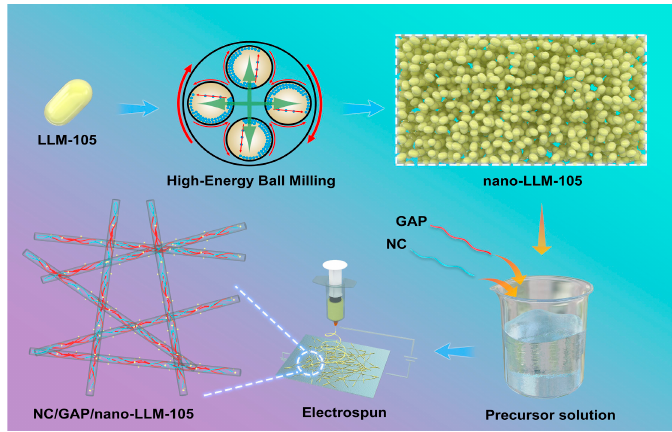
Figure 1. Sketch for the synthesis of the nitrocellulose/glycidyl azide polymer/nano 2,6-diamino-3,5-dinitropyrazine-1-oxide (NC/GAP/nano-LLM-105) composite nanofiber.